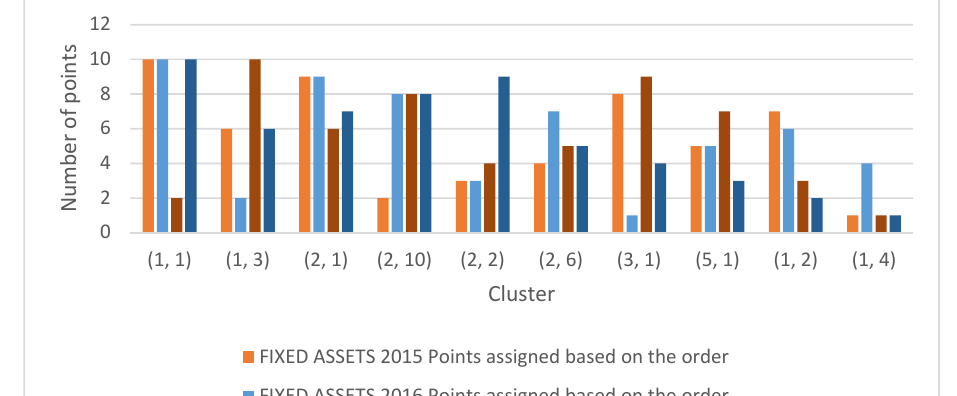
FIXED ASSETS 2015 Points assigned based on the order FIXED ASSETS 2016 Points assigned based on the order FIXED ASSETS 2017 Points assigned based on the order FIXED ASSETS 2018 Points assigned based on the order